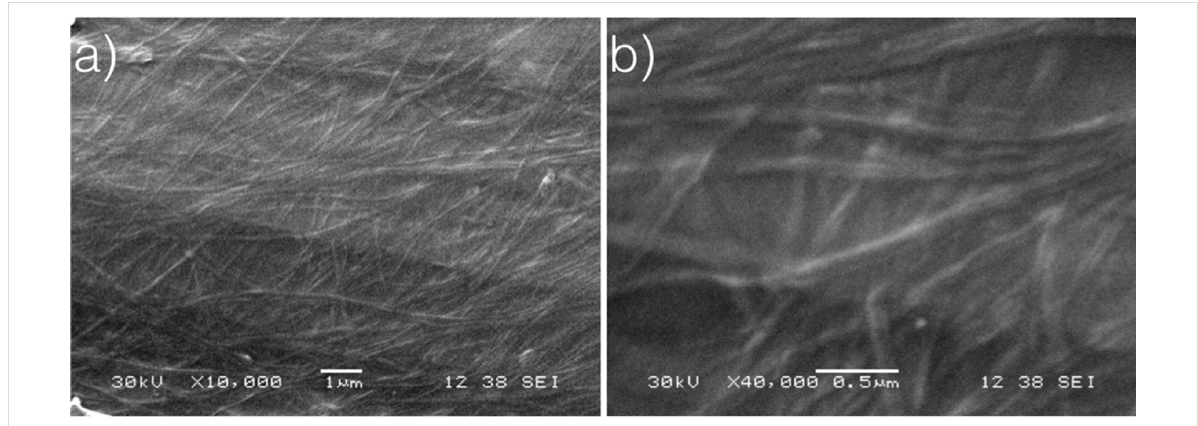
Figure 2: Scanning electron microscopy (SEM) images of PAM2 xerogel in cyclohexane (10 mg/mL). Scales are a) 1 μ m and b) 0.5 μ m.